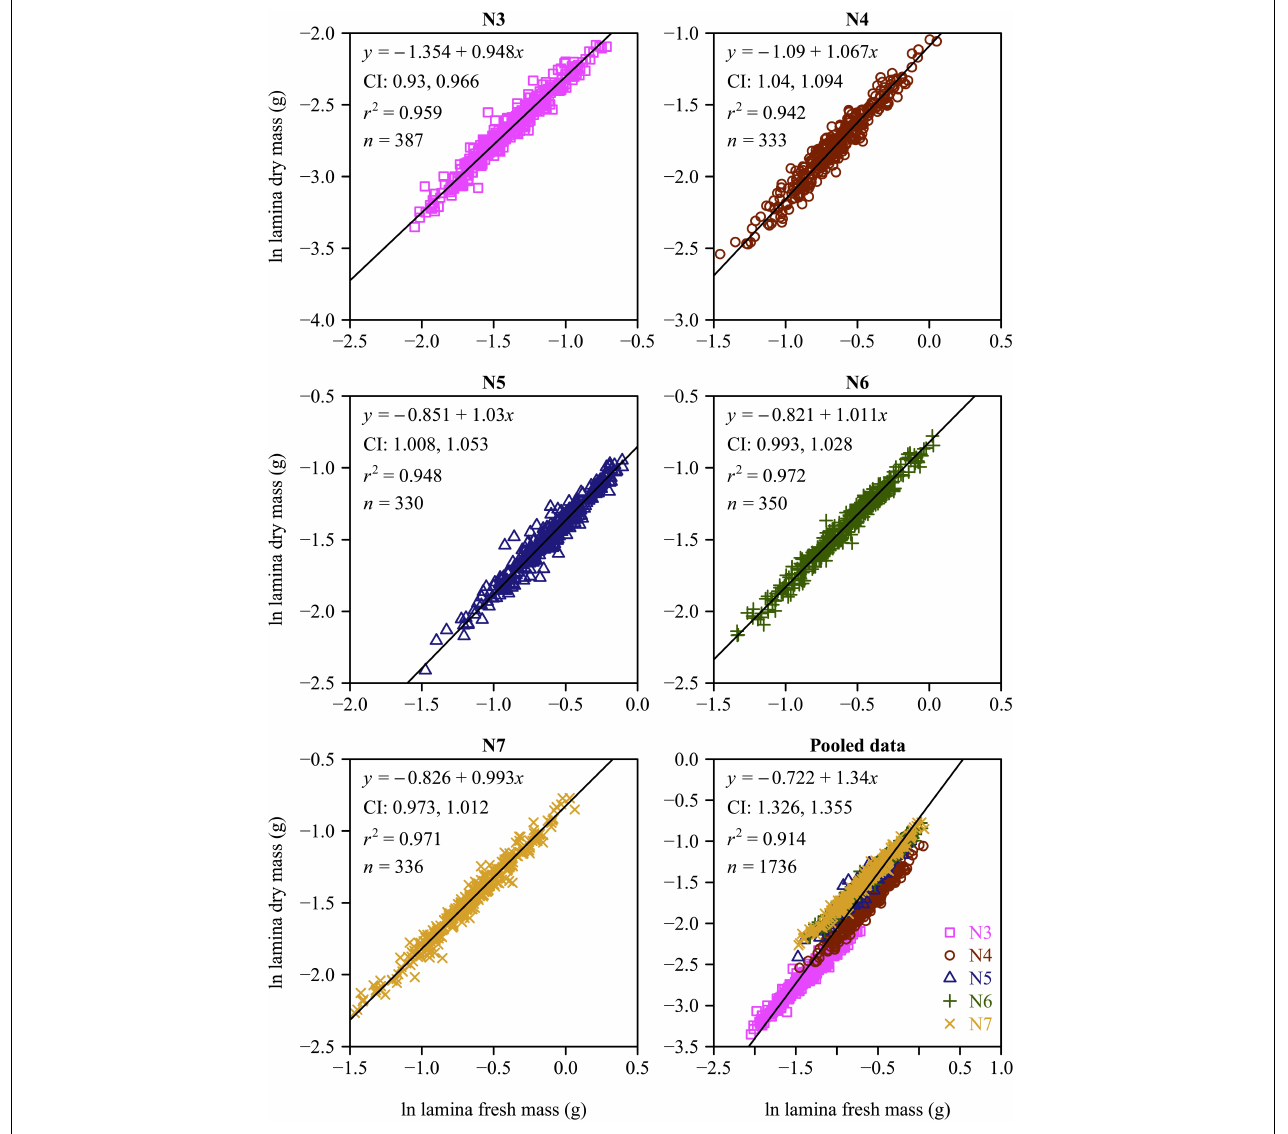
FIGURE 3 | Fitted scaling relationships between lamina dry mass and lamina fresh mass for the five leaf-age groups. The small open circles represent log-transformed values of lamina dry mass vs. lamina fresh mass; the red straight lines represent the regression lines; CI represents the 95% confidence intervals of the slope; r 2 is the coefficient of determination; and n is the sample